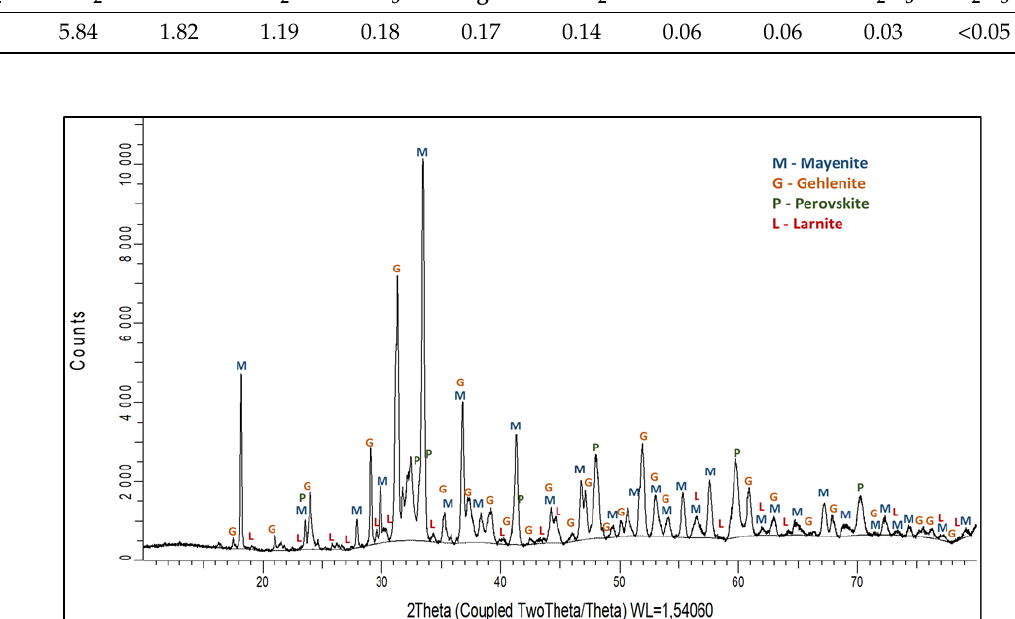
Table 2. XRF quantitative analysis of slag (wt%). Table 2 . XRF quantitative analysis of slag (wt%) .